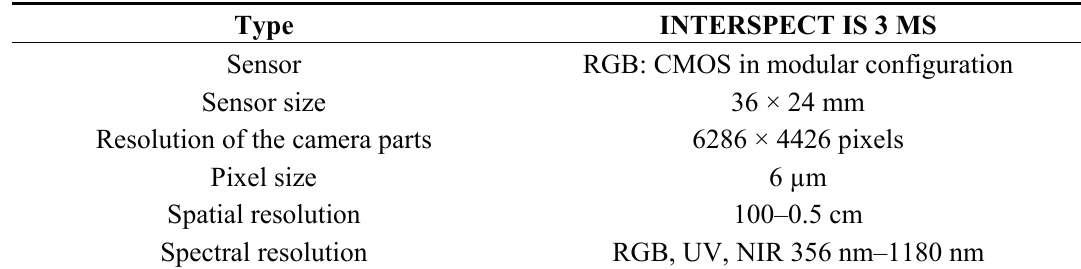
Table 1. The test-relevant data of the IS 3 test frame camera